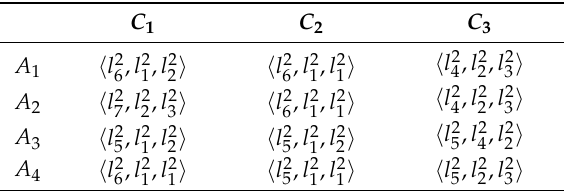
Table 3. The LNN decision matrix R 2 of the expert E 2 .